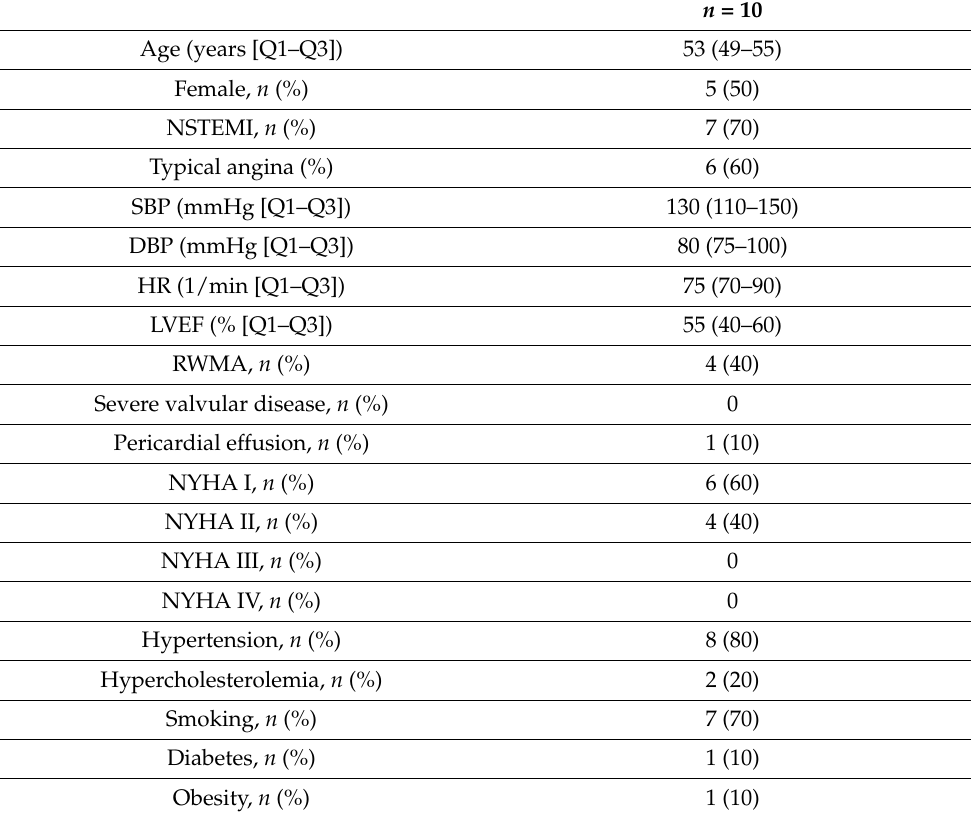
Table 1. Baseline